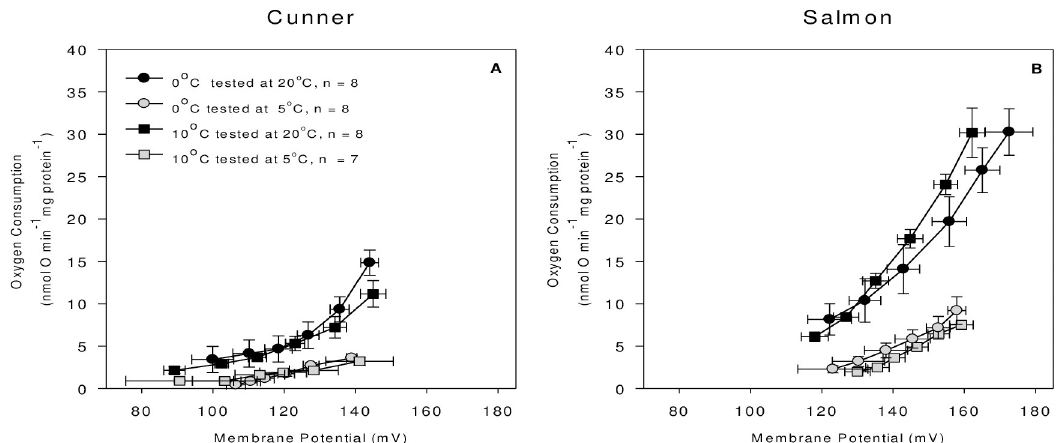
Fig 3. Kinetics of proton leak. Parallel measurements of O 2 consumption (i.e., succinate oxidation) and membrane potential of isolated liver mitochondria from 0 and 10˚C acclimated cunner (A) and salmon (B), measured at 5˚C and 20˚C. Maximal proton leak rates are indicated by the top right-most points. There were no significant acclimation effects. Values are means ± s.e.m., N = 7–8.